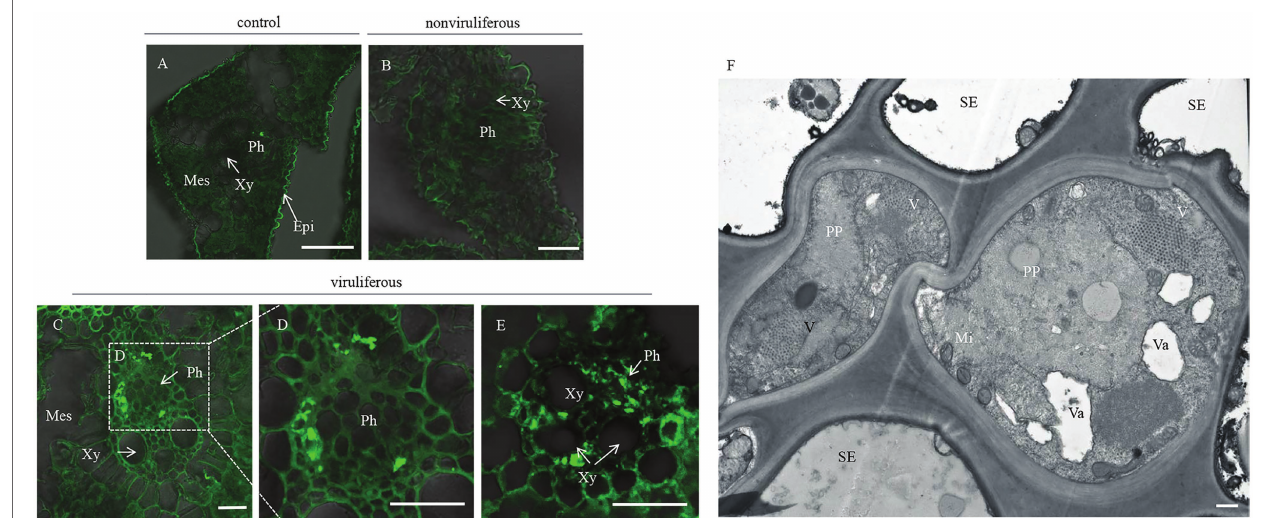
FIGURE 4 | Rice gall dwarf virus distribution in rice phloem after infested by viruliferous R. dorsalis . (A–E) Immunofluorescence detection of RGDV in the cross- sections prepared from leaf phloem infested with nonviruliferous or viruliferous R. dorsalis . Nonviruliferous (B) or viruliferous (C–E) R. dorsalis adults were fed on healthy rice plants for 3 days, which were then processed for immunofluorescence with RGDV P8 antibody conjugated to fluorescein isothiocyanate (FITC). Non-infested healthy rice leaves served as a control. Xy, xylem; Ph, phloem; Mes, mesophyll. (F) The distribution of RGDV particles in rice phloem parenchyma was observed by